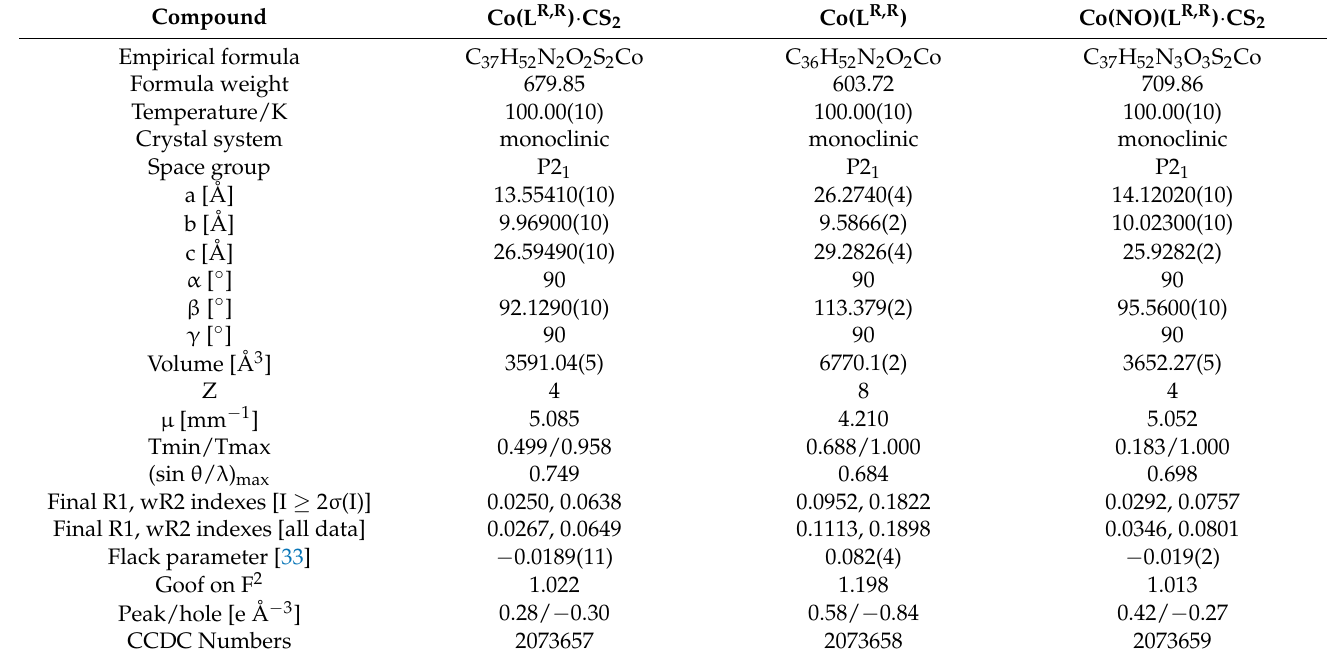
Table 1. Selected crystallographic data for Co(L R,R ) · CS 2 , Co(L R,R ), and Co(NO)(L R,R ) · CS 2 . All data obtained using Cu K α